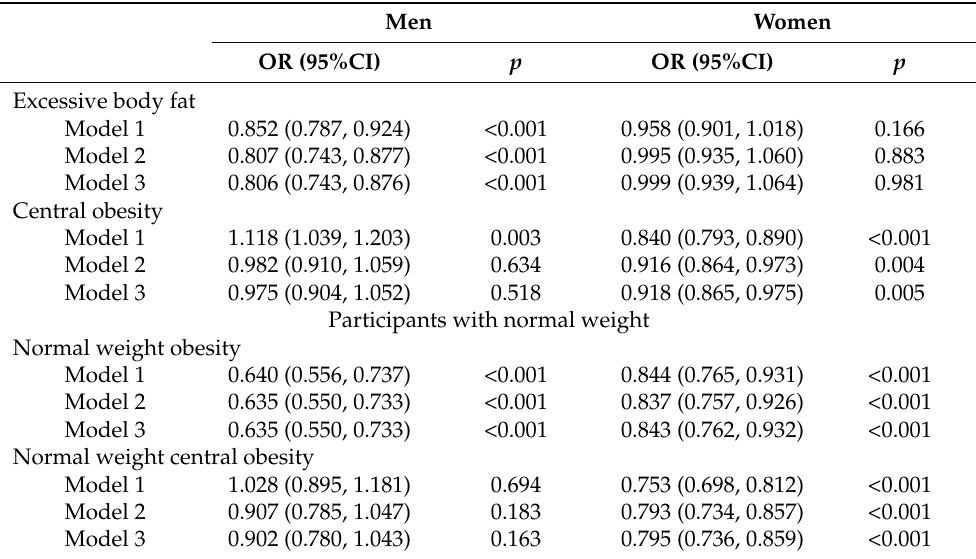
Table 2. The associations of replacing wheat intake (5 times/week) for equivalent frequency of rice with excessive body fat, central obesity, normal-weight obesity, and normal-weight central obesity by sex. Men Women OR (95%CI) p OR (95%CI) p Excessive body fat Model 1 0.852 (0.787, 0.924)